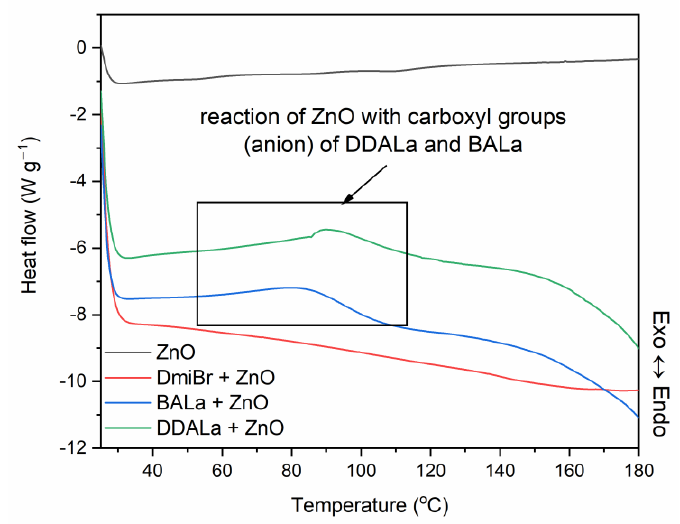
Figure 2. Differential scanning calorimetry (DSC) curves for pure DDALa and BALa.